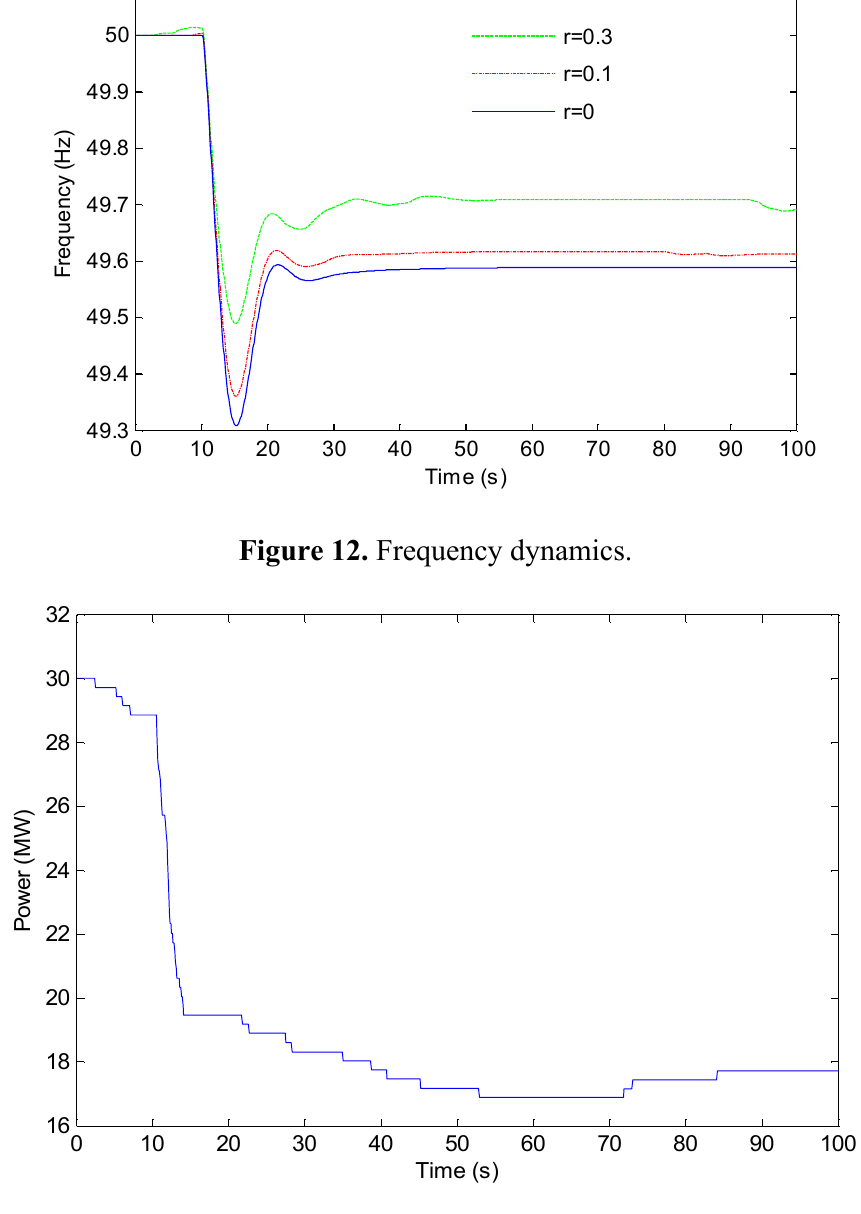
Figure 13. The demand of air conditioners after the